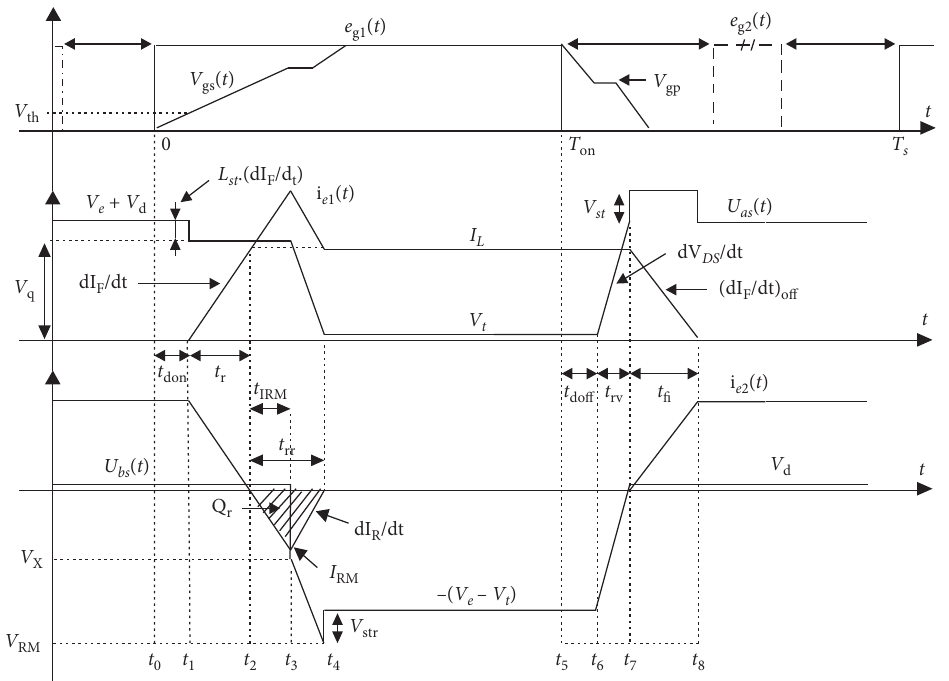
Figure 7: Adopted switching characteristics for the controlled switch and the diode components in the PWM-switch cell.